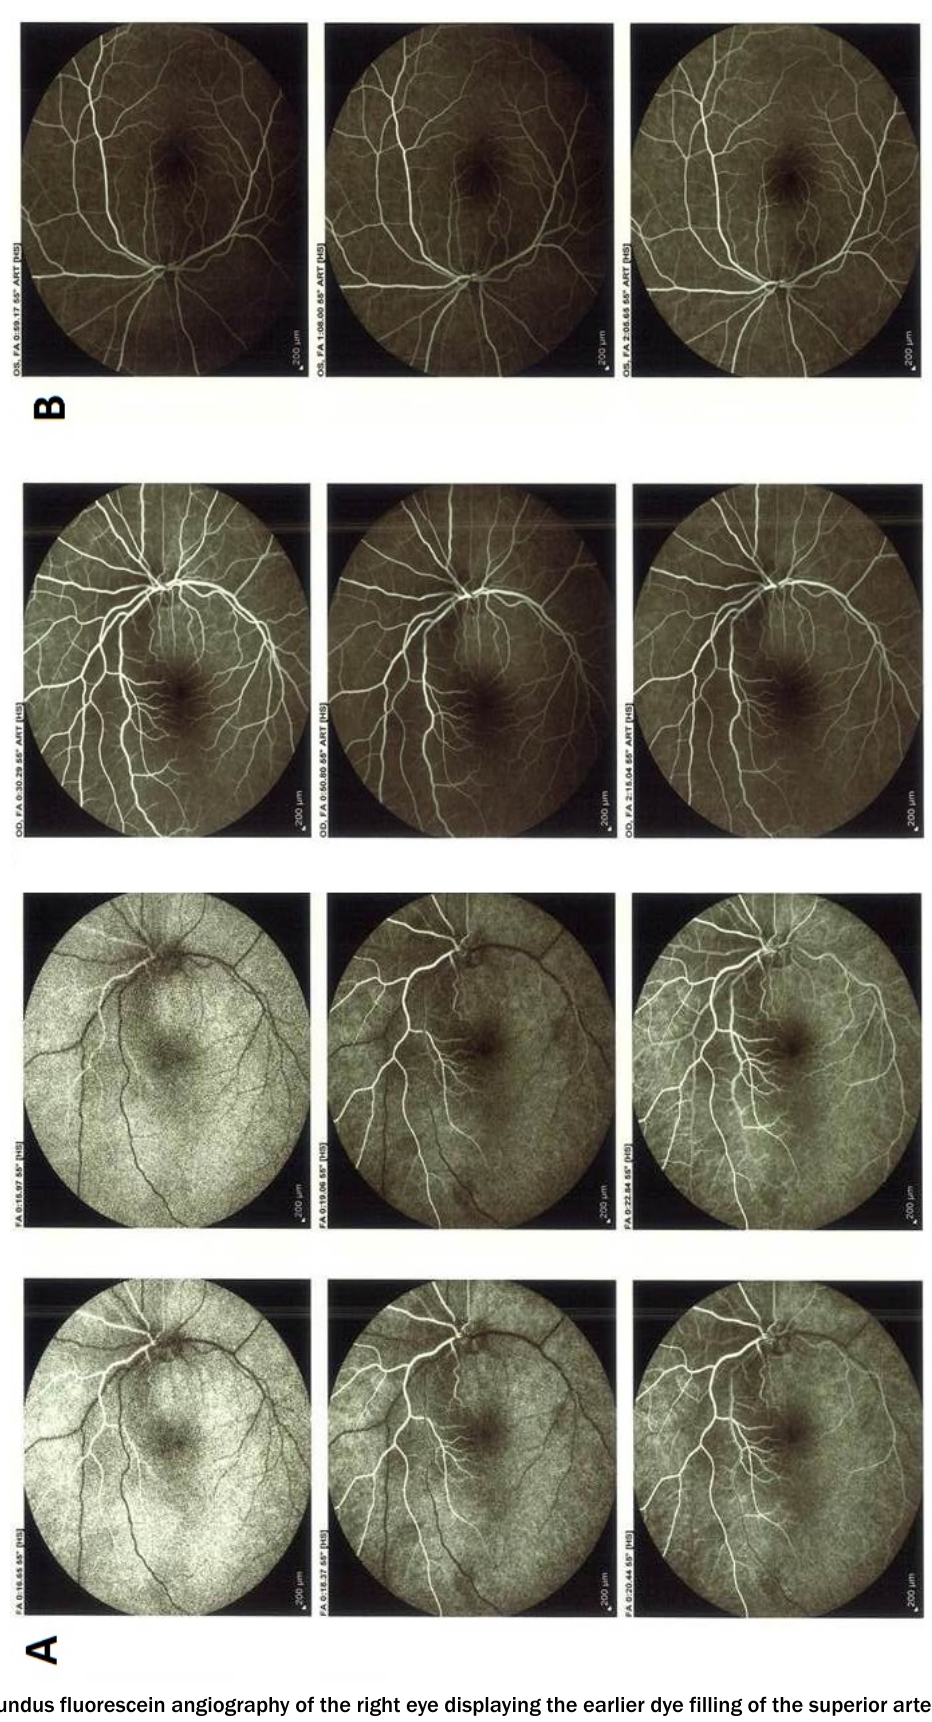
Figure 3: A: Fundus fluorescein angiography of the right eye displaying the earlier dye filling of the superior arterial hemi-trunk and its main branches in the choroidal phase. Dye appearance in inferior retinal arterial vasculature occurred a few seconds later in the arterial phase. B: Fluorescein filling of the left eye. No filling defect was detected in